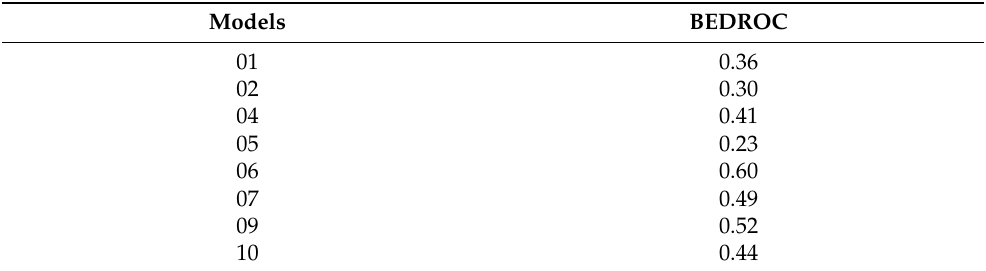
Table 2. BEDROC value of pharmacophore models, considering α = 16.10.